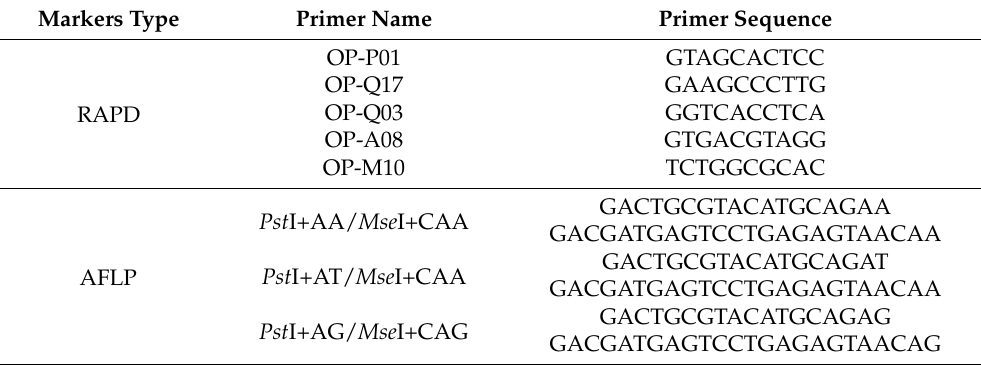
Table 1. List of RAPD primers and AFLP primer combinations (with restriction enzymes) used for genomic DNA